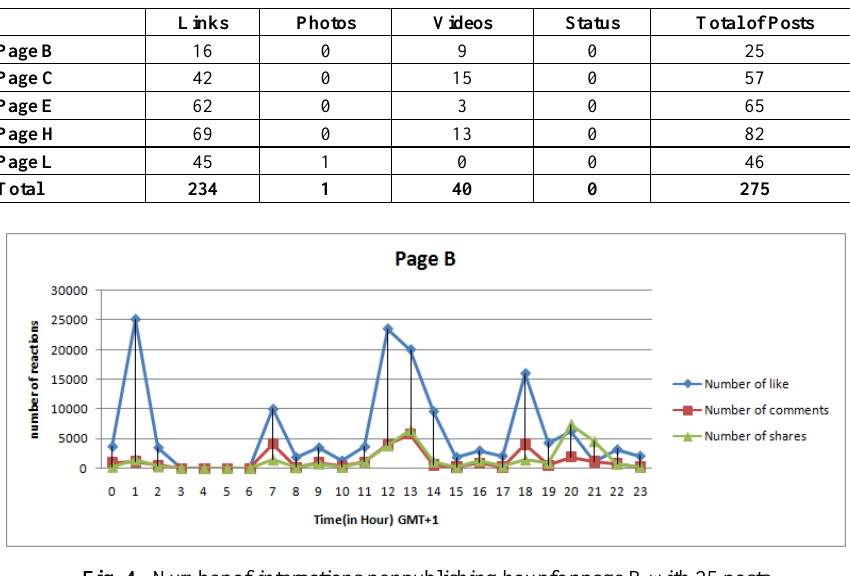
Fig. 4. Number of interactions per publishing hour for page B with 25